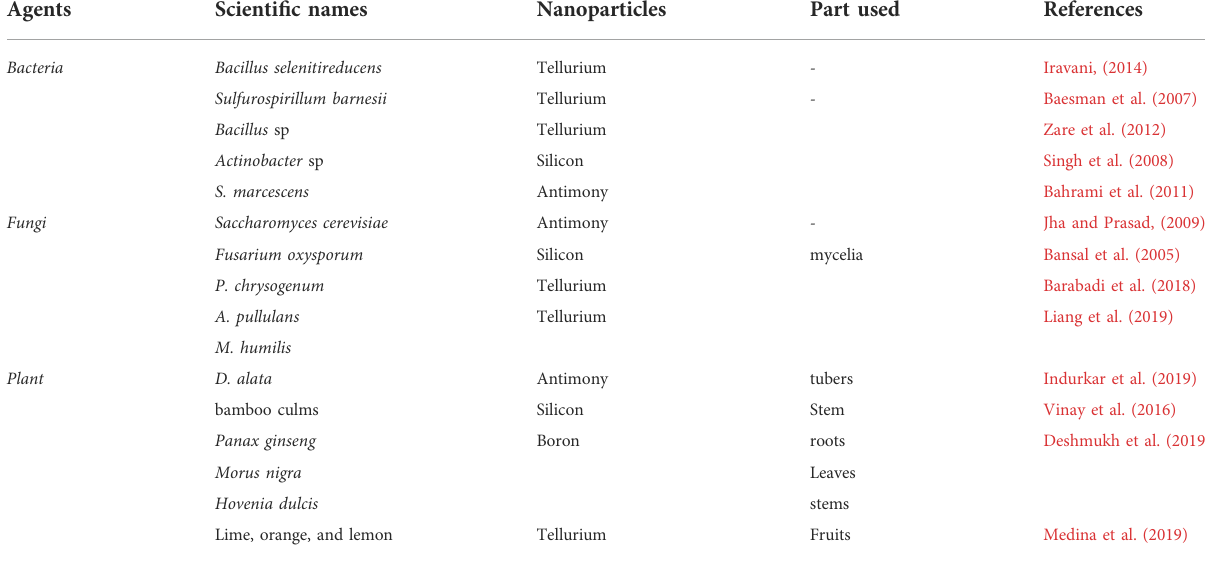
TABLE 1 A comparative table for metalloid synthesised from different biological agents.